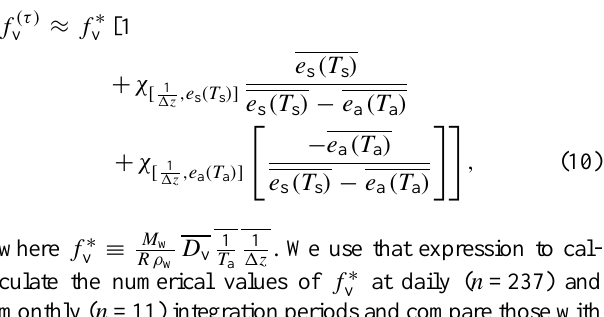
, e s (T s ) ; (g) 1 , e a (T a ) ; (h) 1 , e s (T s ) 1z T a T a